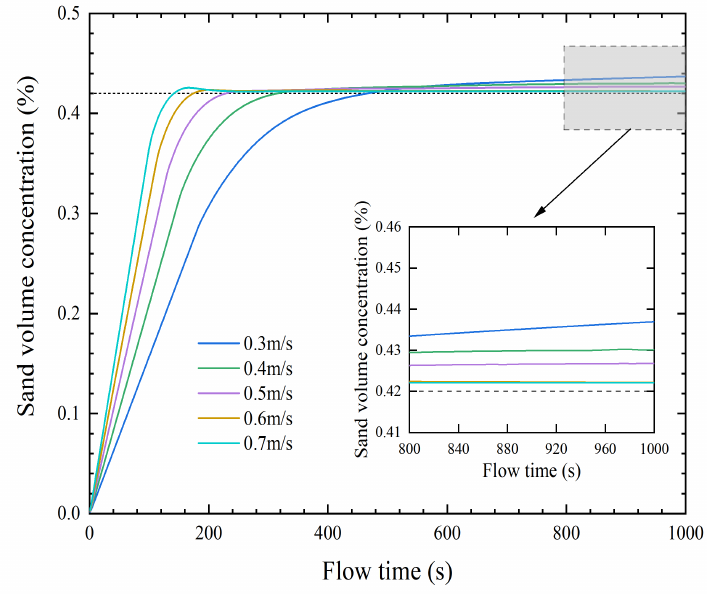
Figure 8. Sand volume concentration changes with flow time (V-inclined pipe L = 80 m d = 0.02